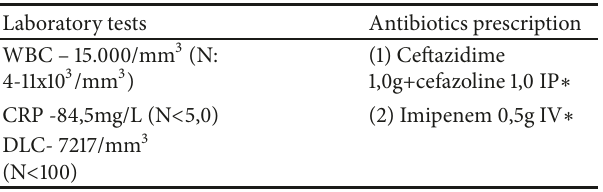
Table 1: Laboratory investigation and antibiotics treatment in the first episode of A. xylosoxidans peritonitis in patient